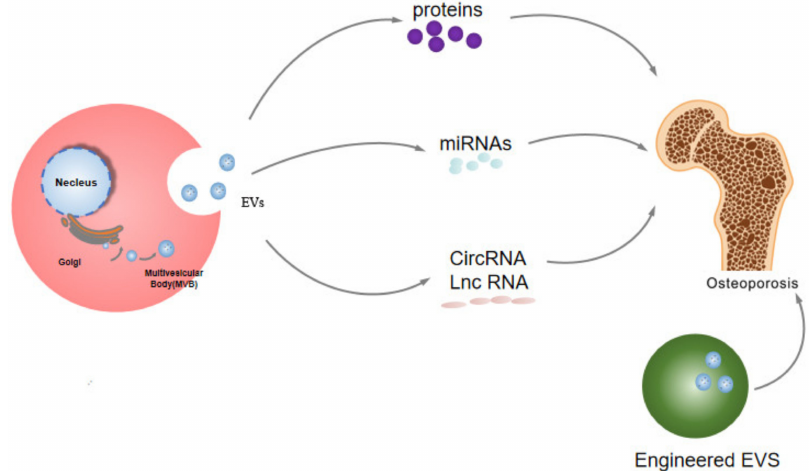
Figure 2. The potential therapeutic effects of EVs in